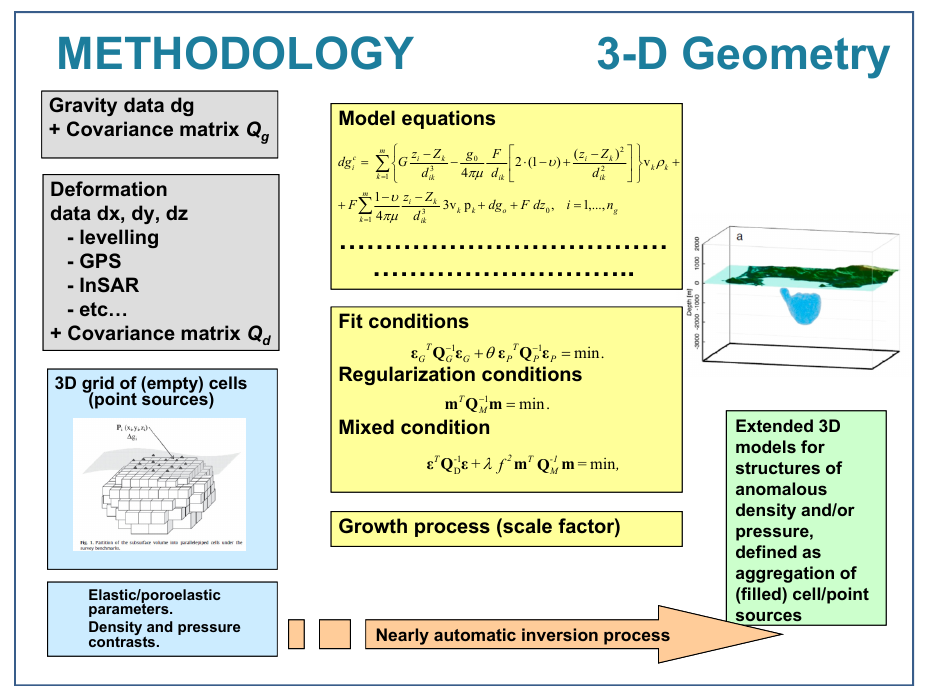
Figure 26. Schematic flow diagram of the described inversion methodology [1,5,17,53,54] where we start from the data set, the medium characteristics and its 3D gridding, to get (using the direct model equations and complementary conditions) a 3D source model of the anomalous sources via a growth